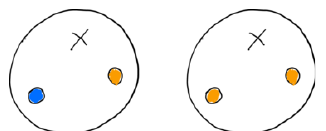
Figure 6 . Two di(cid:11)erent trinions with two maximal and one minimal punctures. On the right we have interacting trinion with two maximal punctures of same color. This is su (2) SQCD with four (cid:13)avors and certain choice of singlets [9]. The trinion on the right is the free one with two maximal punctures of di(cid:11)erent